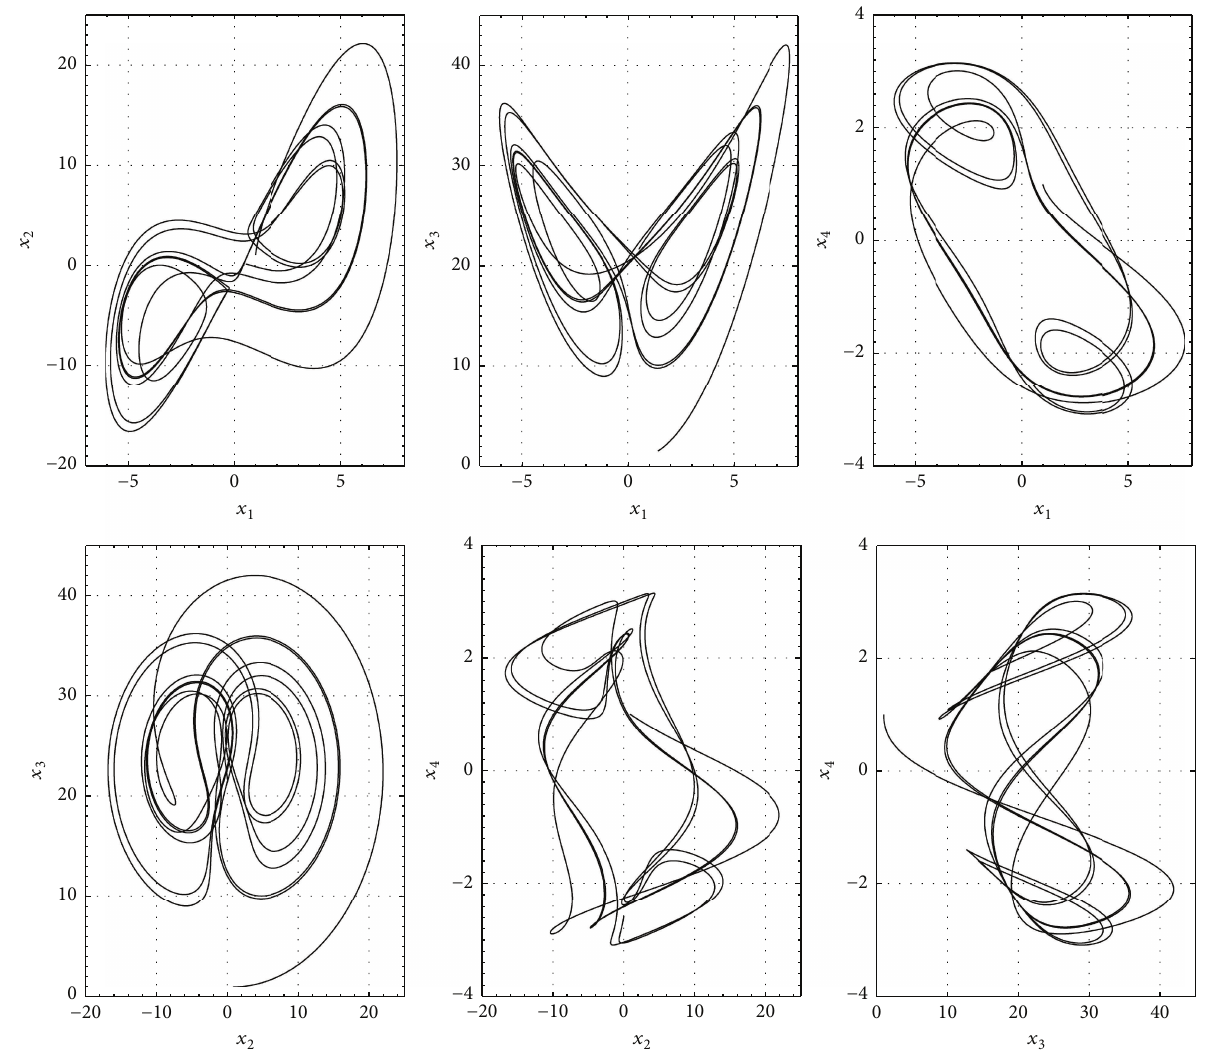
Figure 1: Phase space of the hyperchaotic Lorenz-Stenflo system